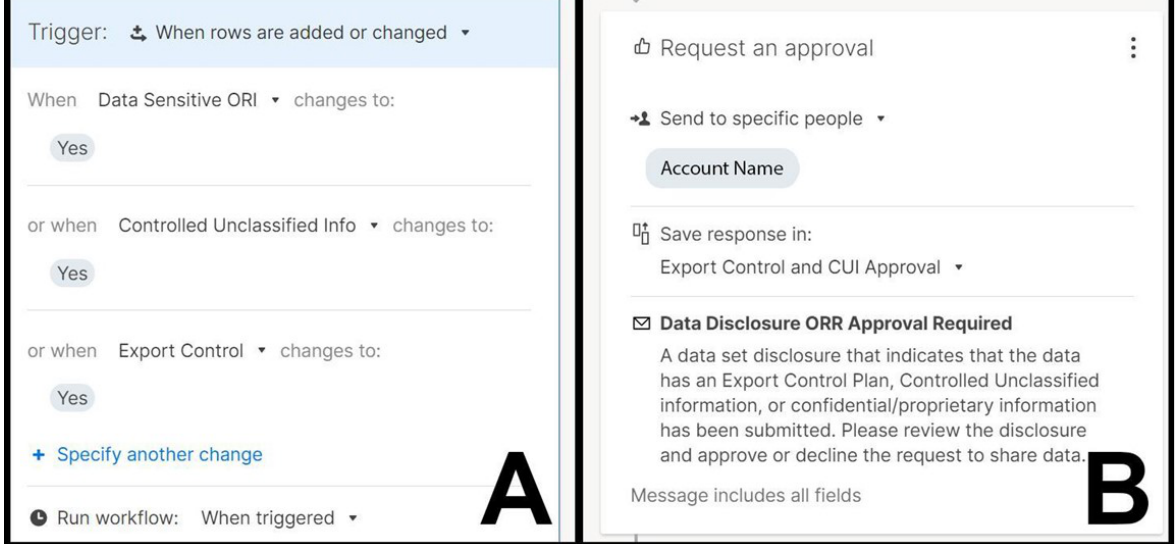
Figure 1 : A screenshot of Smartsheet showing A) the conditions needed to trigger the approve/decline email message and B) the text of the email message and how the response is stored in the